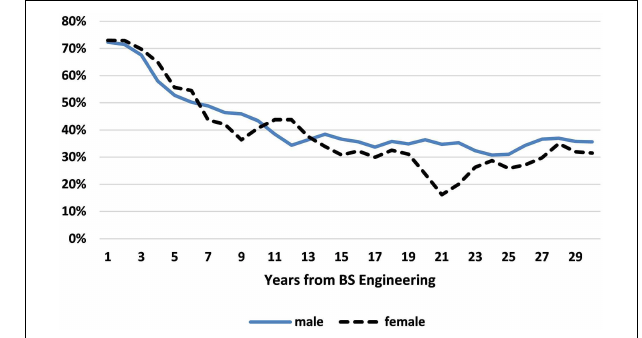
FIGURE 3 | Percent of female and male Bachelors of Engineering (BSEs) working full time who remain in engineering, by years from BSE. Data Source: NSF SESTAT Surveys